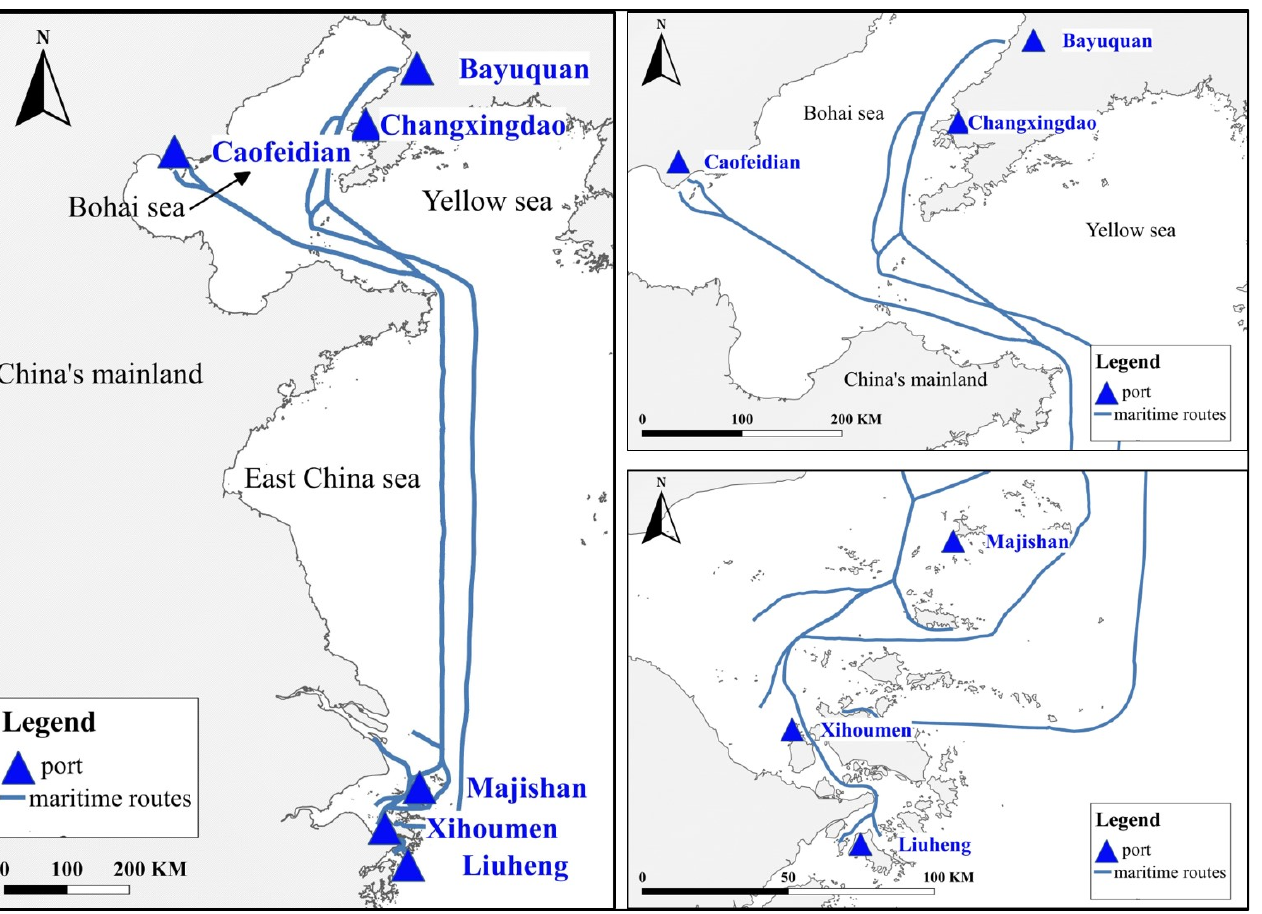
Figure 10. Maritime route extraction results.